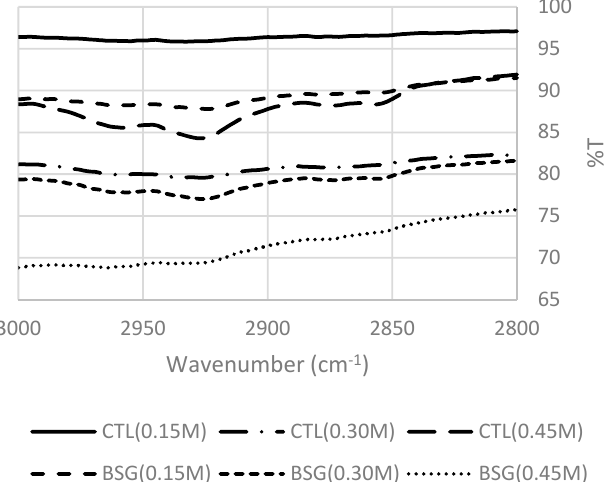
Figure 4. FTIR (wavenumber 3000–2800 cm − 1 ) of low-fat sausages with basil seed gum at different salt levels. Treatments: CTL(0.15 M), myofibrillar protein mixtures (MP) without basil seed gum (BSG) at 0.15 M salt concentration; CTL(0.30 M), MP without BSG at 0.30 M salt concentration; CTL(0.45 M), MP without BSG at 0.45 M salt concentration; BSG(0.15 M), MP with BSG at 0.15 M salt concentration; BSG(0.30 M), MP with BSG at 0.30 M salt concentration; BSG(0.45 M), MP with BSG at 0.45 M salt